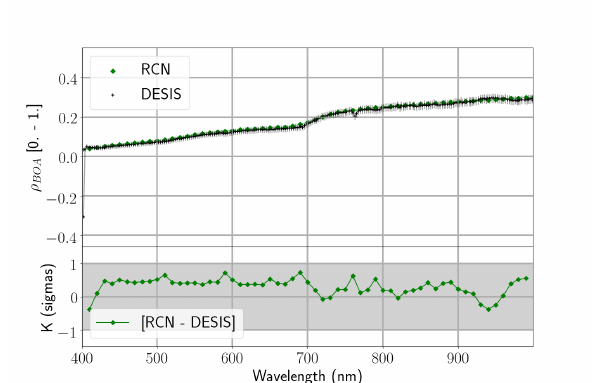
Figure 5. Top: DESIS surface reflectance (black cross) and RadCalNet (green diamond) in-situ measurement for La Crau (France) on June 20 th , 2020. Bottom: Residuals of the difference between the spectra